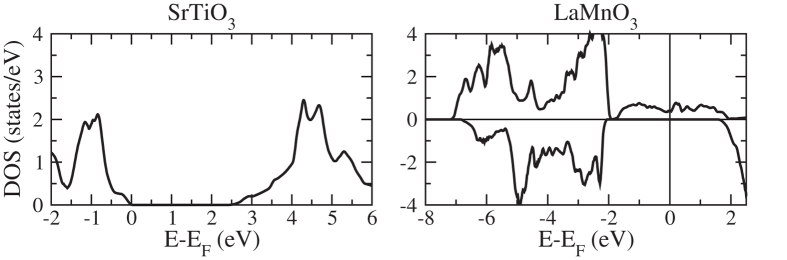
Total densities of states of bulk SrTiO3 and strained bulk LaMnO3.